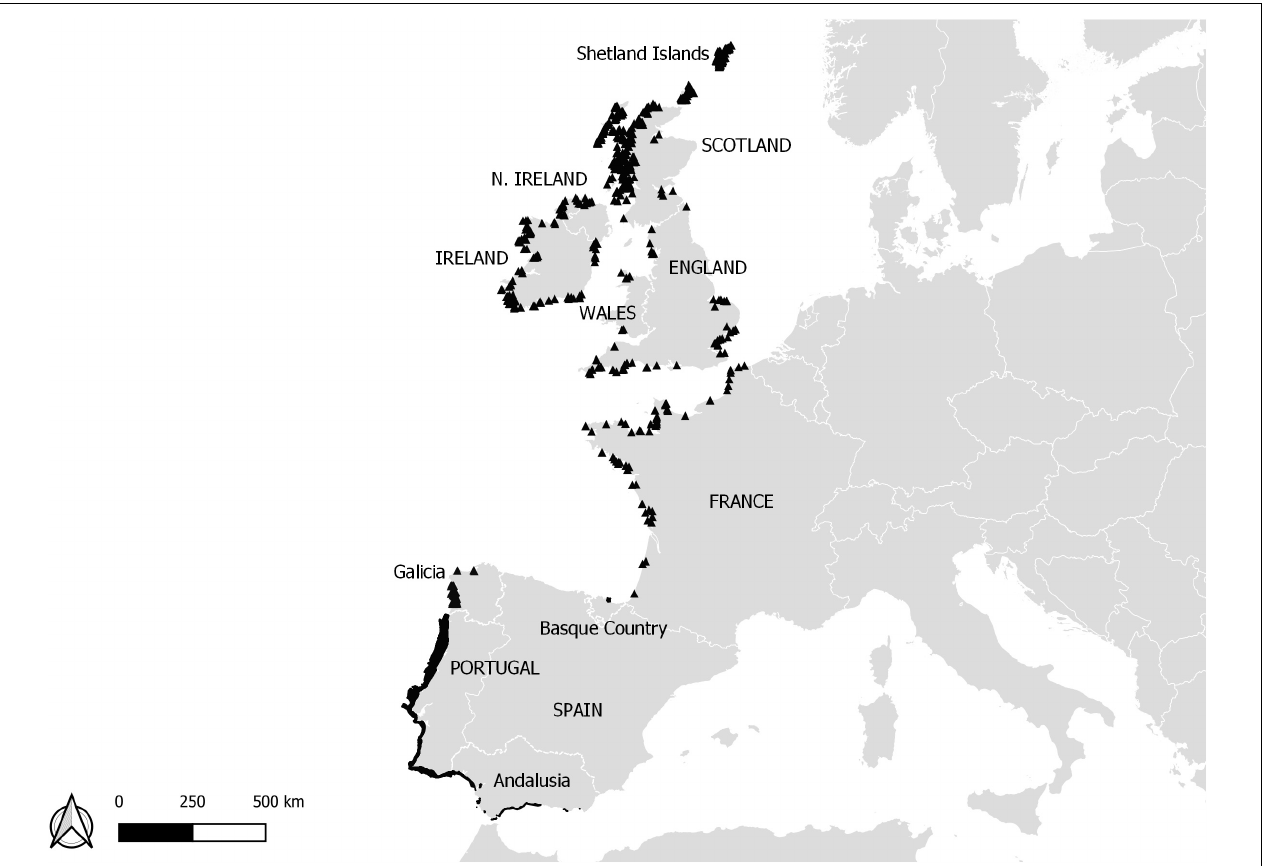
FIGURE 1 | Spread of shellfish aquaculture production in Atlantic areas of Scotland, Ireland (North Ireland not included), England, France, Spain, and Portugal. The data providers are: Marine Institute in Ireland, Ifremer (from Euroshell project, 2013) in France and England the Scottish Government, Marine Environment and Technology Centre in Portugal, Junta de Andalucía in Andalusia, and AZTI in the Basque Country. Countries names are highlighted in capital letters, whereas regions are not.